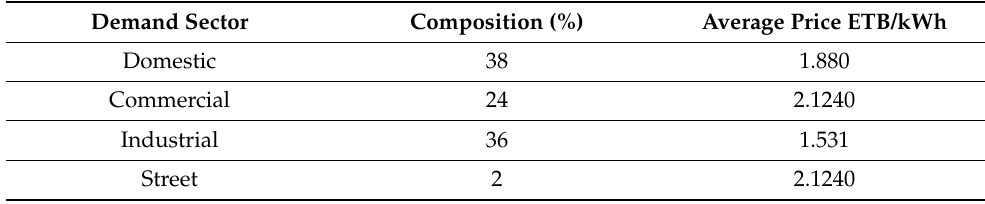
Table 1. An internal demand composition and average